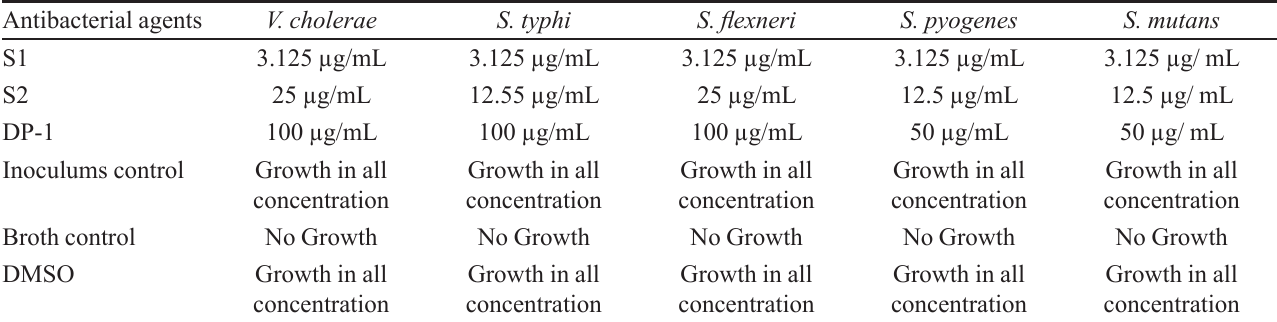
TABLE IV - Comparatives evaluation of MIC values of D. Pentaphylla methanol extract, DP1 along with standards Antibacterial agents